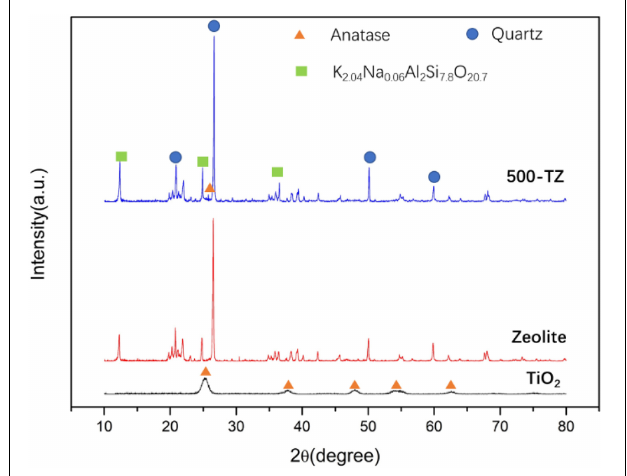
FIGURE 1 | Schematic diagram of the TiO 2 @zeolite composite coated PCM. FIGURE 2 | X-ray diffraction patterns of TiO 2 , Zeolite, and